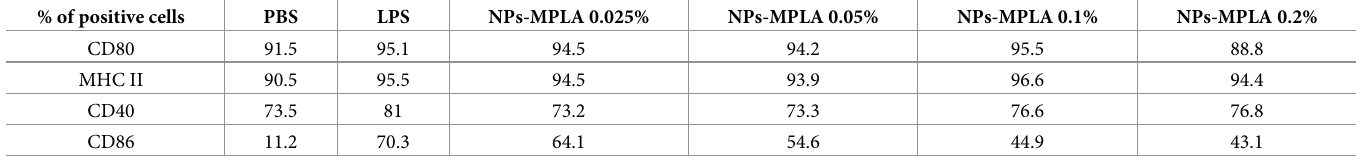
Table 2. Example of percentages of positive cells for CD80, MHC II, CD40, and CD86, 24 h after contact with PBS (negative control), LPS (positive control at 1 μ g/ ml), and NPs-MPLA at 4 different loading ratios of MPLA. % of positive